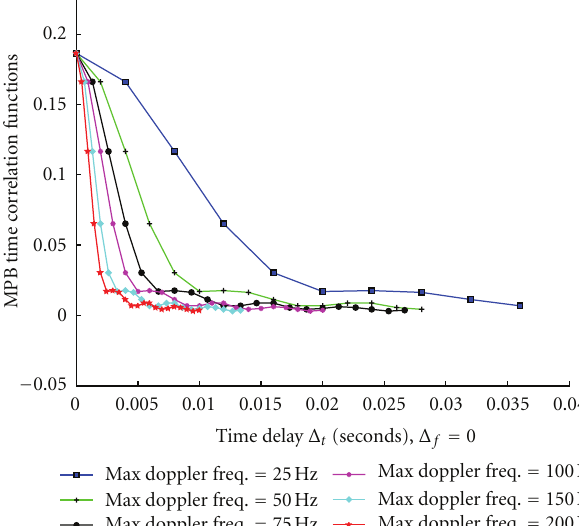
Figure 10: Normalized time-correlation functions varying with the time delay and the maximum Doppler Tx/Rx frequencies for DB ray. The configuration is defined in Table 1 with η t = η r = η t r = 1/3.